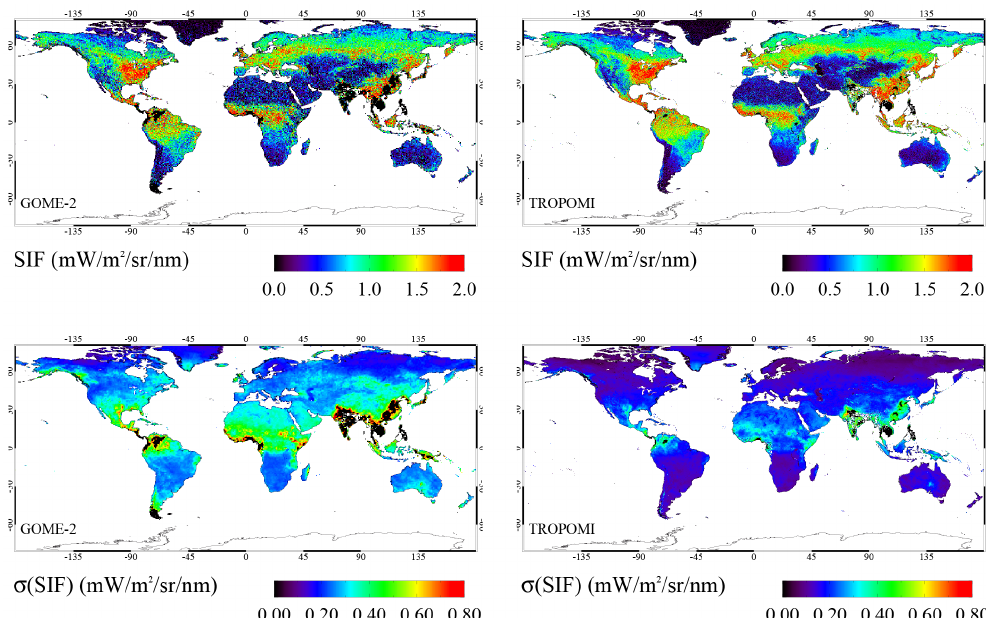
Figure 11. Global composites of mean SIF and standard error of the mean ( σ (SIF)) for the 735–758nm fitting window and the same conditions of Fig. 10, except that the measurement time for GOME-2 is set to 13h in order to compare with TROPOMI under the same illumination